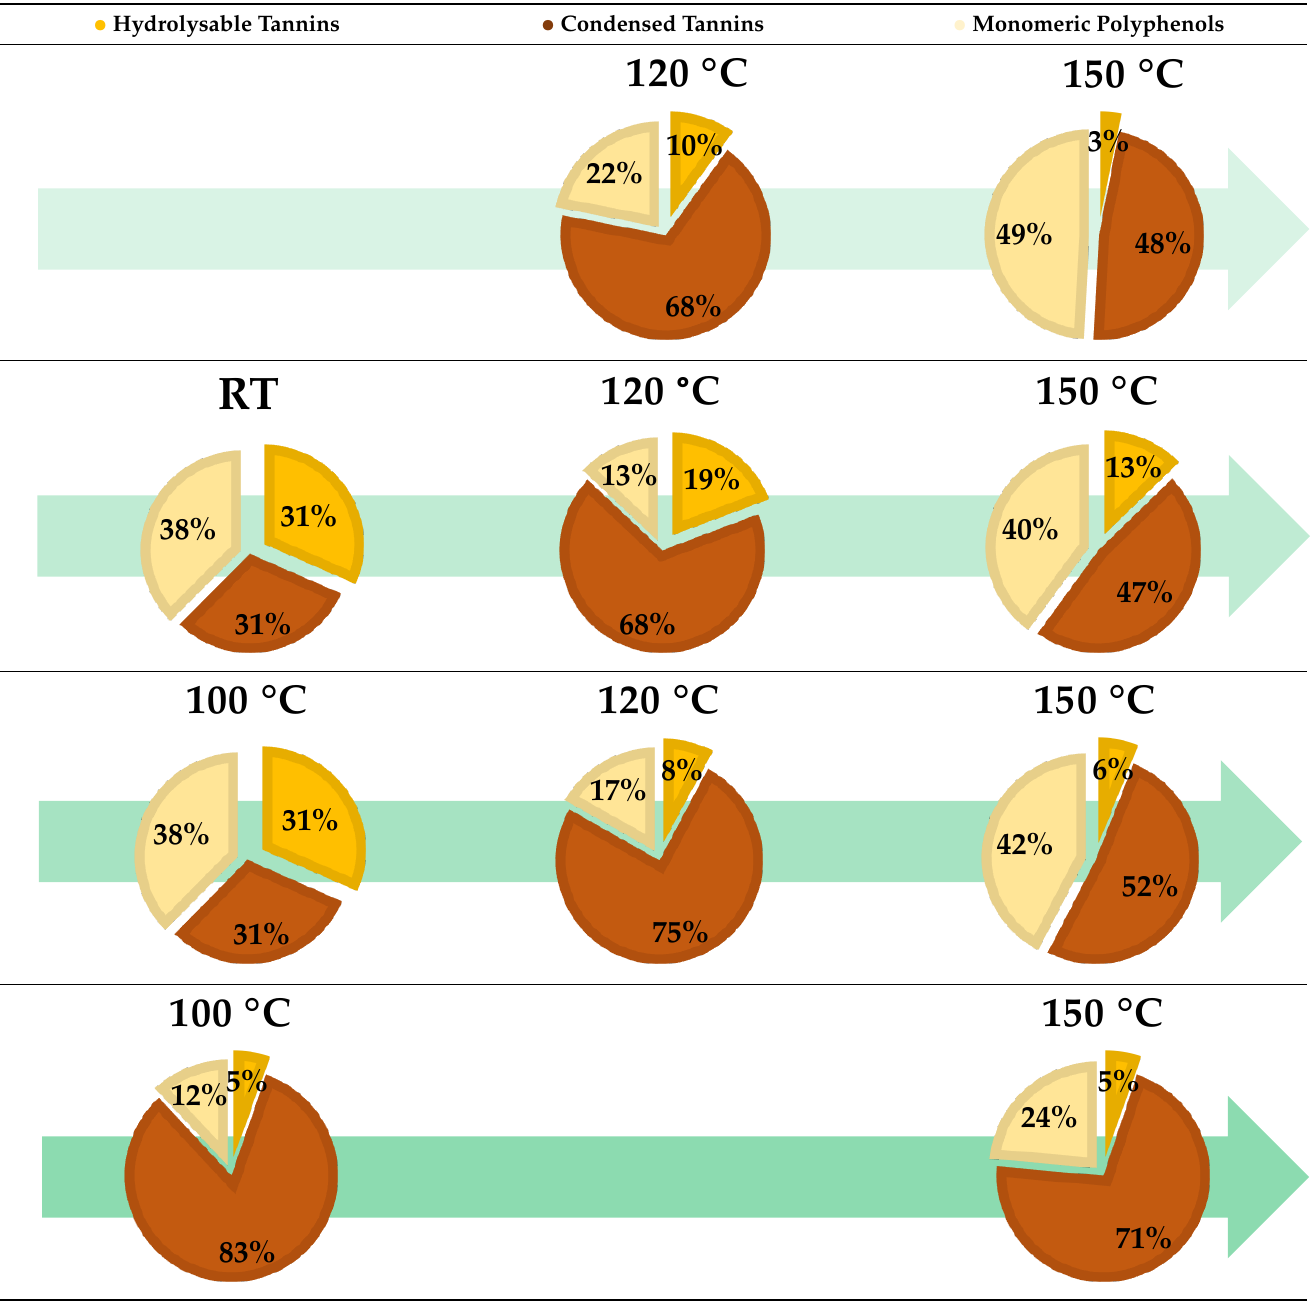
Table 7. Distribution of HTs and CTs and monomeric polyphenols.